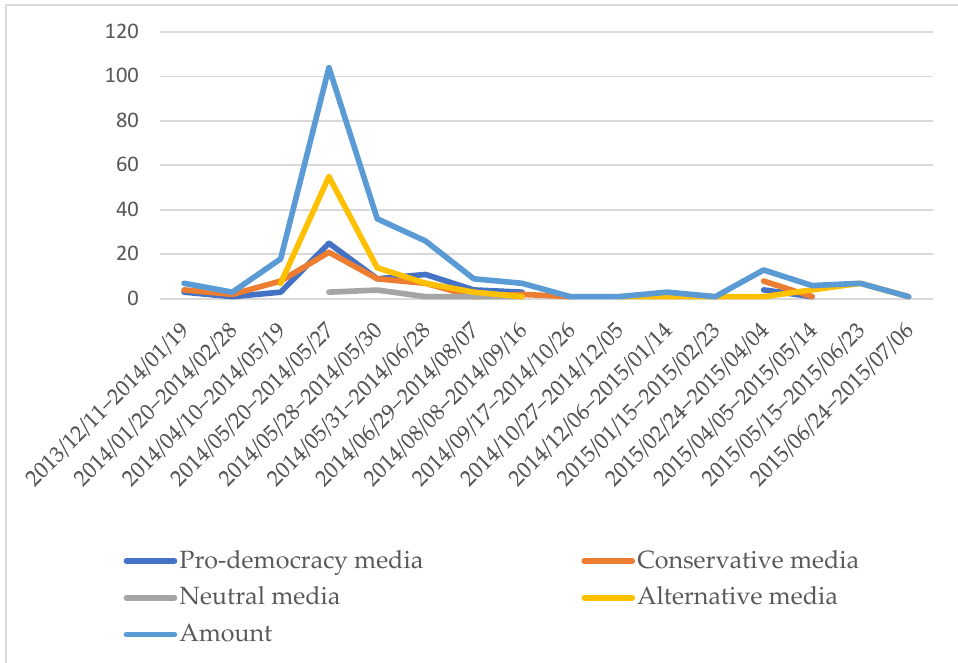
Figure 2. Amount of news coverages during the different periods.